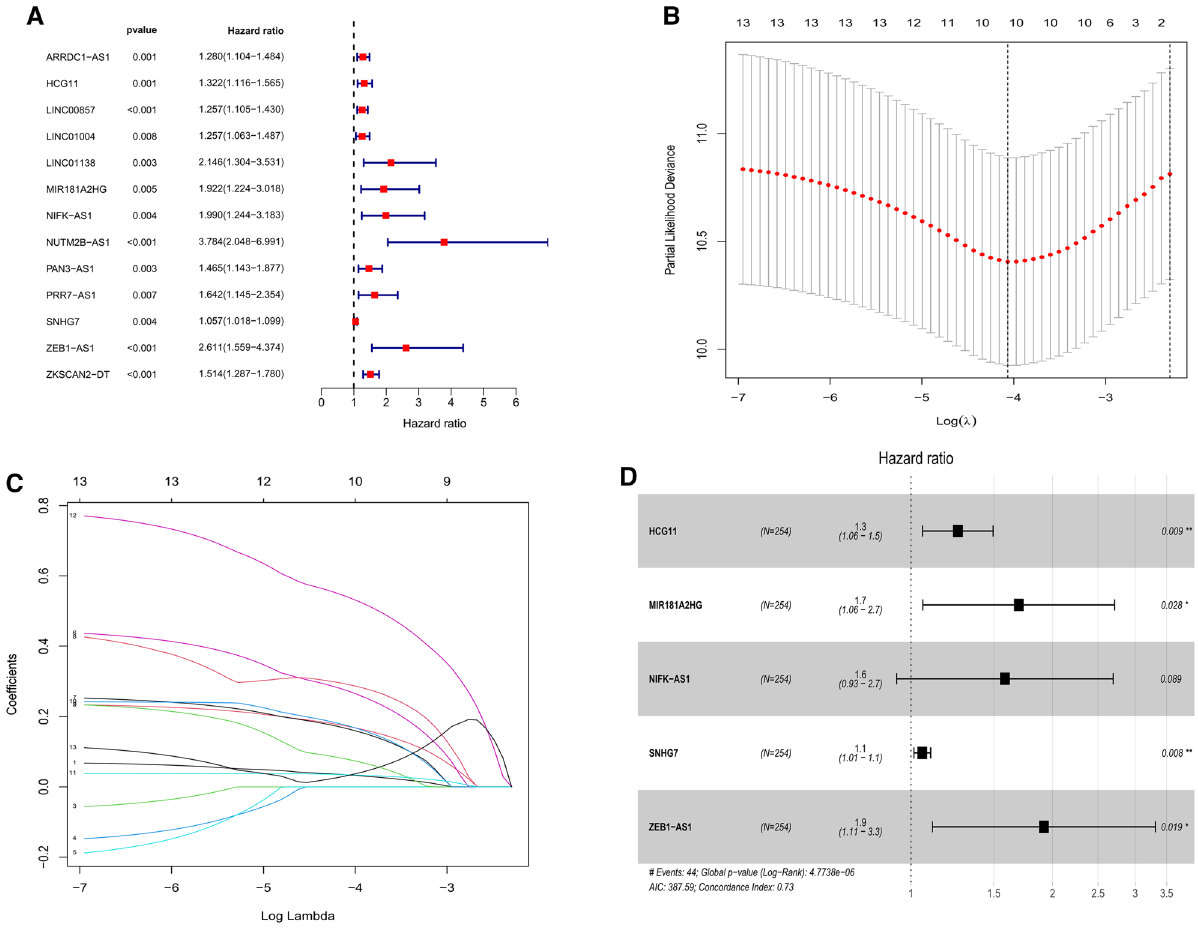
Figure 1. Construction of immune-related lncRNA signature associated with prognosis of patients with CRC. ( A ) Univariate Cox regression models identified 13 immune-related lncRNAs associated with overall survival. ( B,C ) Lasso regression analysis identified 10 immune-related lncRNAs. ( D ) Multivariate Cox regression models identified five immune-related lncRNAs to construct the prognostic signature.